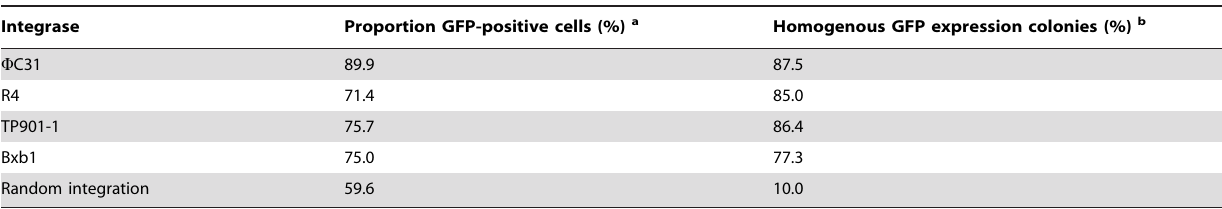
Table 1. GFP expression profiles of the transfected CHO cells.